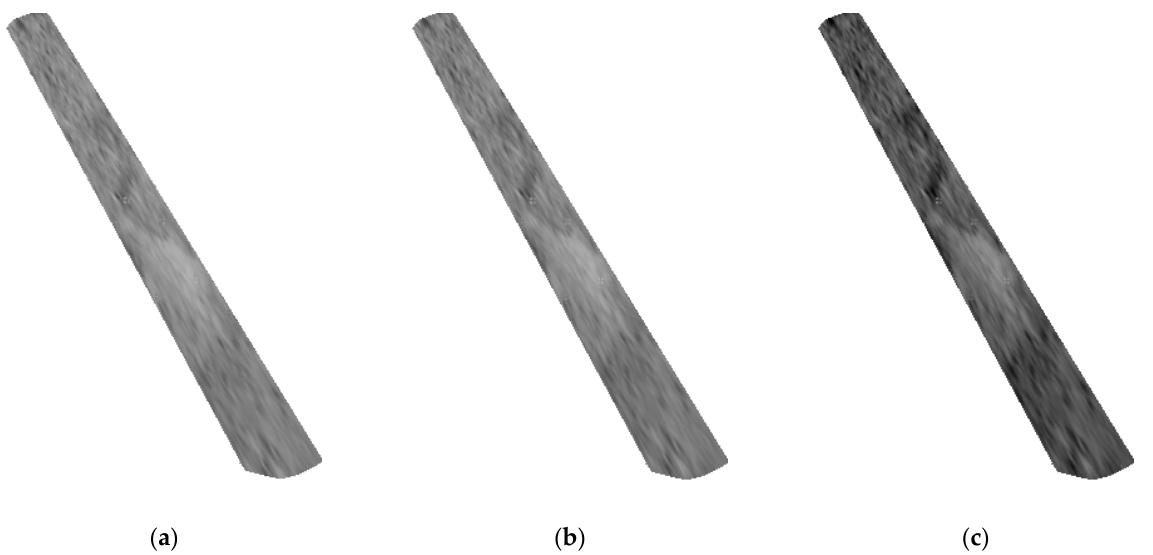
Figure 19. Orthorectified images of ROI 1 in Yutu-2 rover imagery ( a ) ROI 1 of 94741, ( b ) ROI 1 of 94914, ( c ) ROI 1 of 95633.